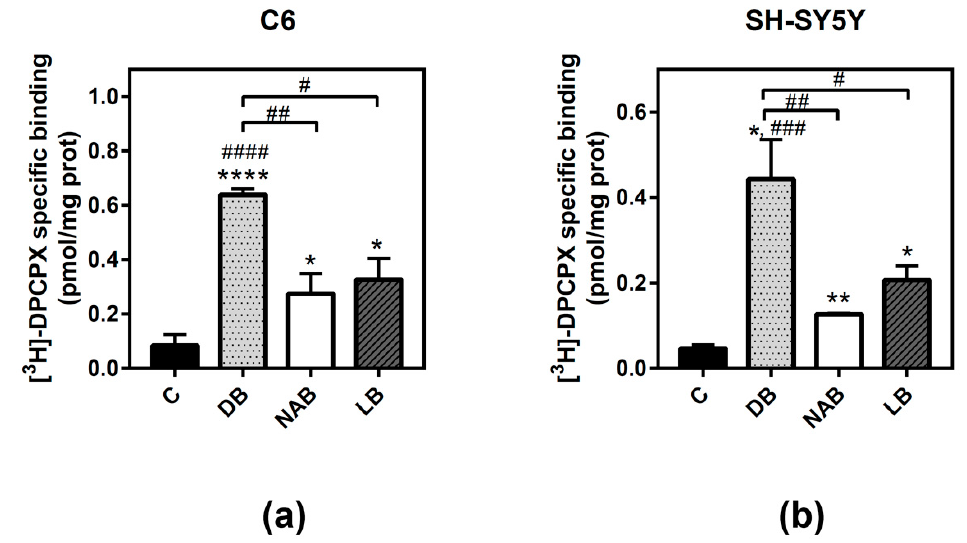
Figure 3. Analysis of adenosine A 1 receptors by radioligand binding assay in C6 and SH-SY5Y cells. Specific binding to A 1 receptors was determined in C6 (panel a ) or SH-SY5Y (panel b ) intact cells at saturating concentration (20 nM) of [ 3 H]-DPCPX, as described in “Materials and Methods”. Nonspecific binding was determined in the presence of 4 mM CPA. The treatments were performed for 24 h with DB, NAB, and LB extracts. Data are means ± SEM of, at least, three independent assays; * p < 0.05, ** p < 0.01, and **** p < 0.0001, significantly different from their corresponding control (C) according to Student’s t test; # p < 0.05, ## p < 0.01, ### p < 0.001, and #### p < 0.0001, significantly different from control (C) or considered bars according to one-way ANOVA test.